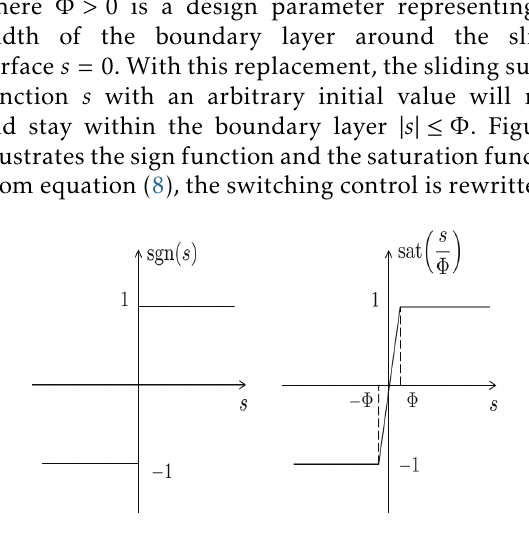
Figure 2. Sign function and saturation